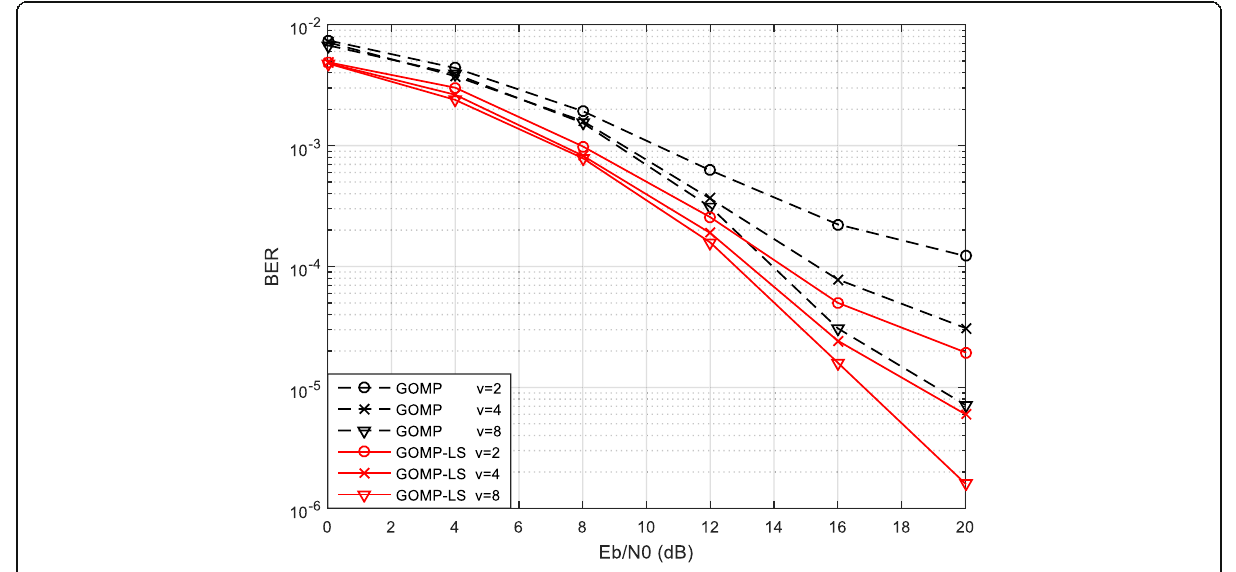
Fig. 5 BER performance of GOMP and GOMP-LS algorithms varying group